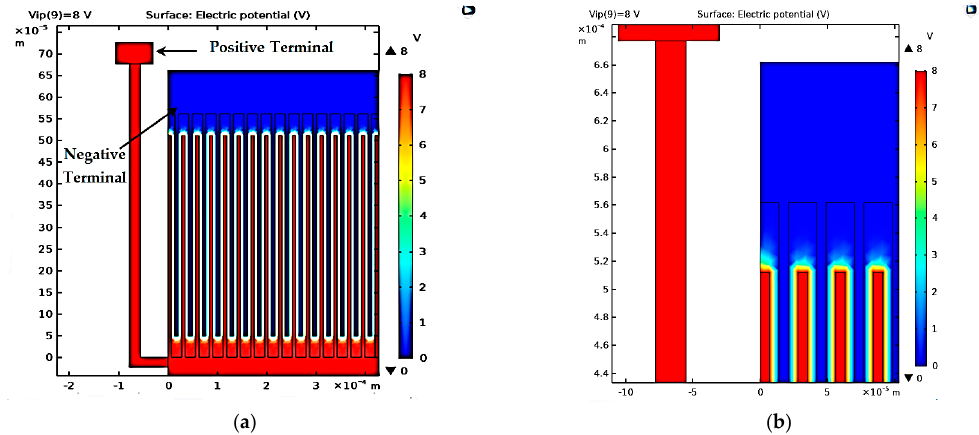
Figure 3. The converter electric potential distribution’s ( a ) overall structure and ( b ) a focus showing a clearer view.